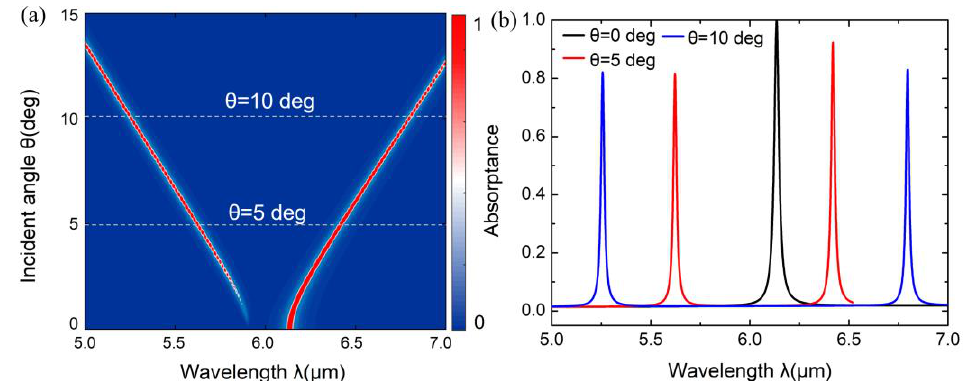
Figure 4. ( a ) Absorptance map of the dielectric-metal metasurface absorber with different incident angle. ( b ) The absorptance spectra with varying incident angle when θ = 0 deg, θ = 5 deg and θ = 10 deg.